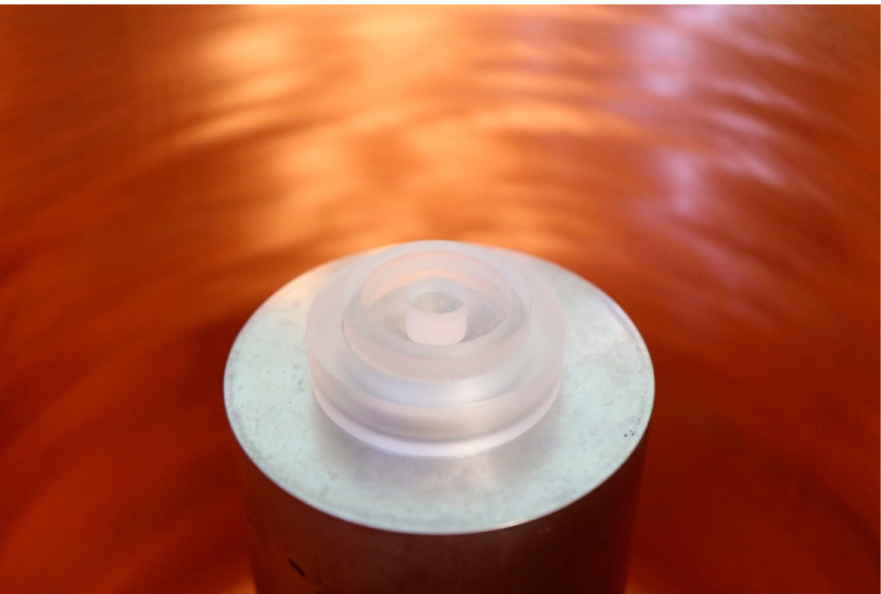
Figure 3. The little jar containing the 4 g of dry residue placed on to the top of HPGe n-type detector. In order to have a standardized and calibrated counting geometry, a fixed quantity (4 g) of dry residue was put in the jar and uniformly distributed in a thin, cylindrically shaped geometry. As the photopeak efficiency was obtained by tracing with a multi- γ standard calibration source 4 g of a soil-type material, no self-absorption corrections were needed. In Figure 4, a typical γ spectrum of a fallout sample is shown: marked in red, a well-shaped 210 Pb γ peak is clearly